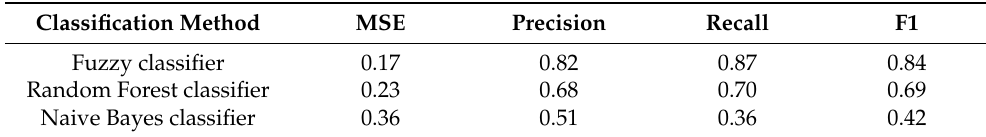
Table 3. Experimental results. Classification system